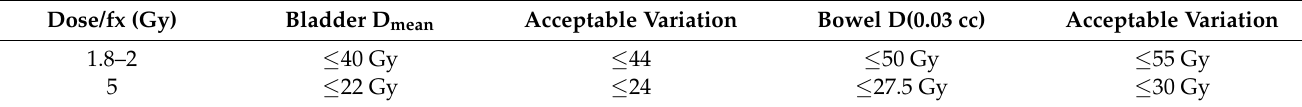
Table 2. OAR dose constraints for plan evaluation based on dose per fraction. Dose/fx (Gy) Bladder D mean Acceptable Variation Bowel D(0.03 cc) Acceptable